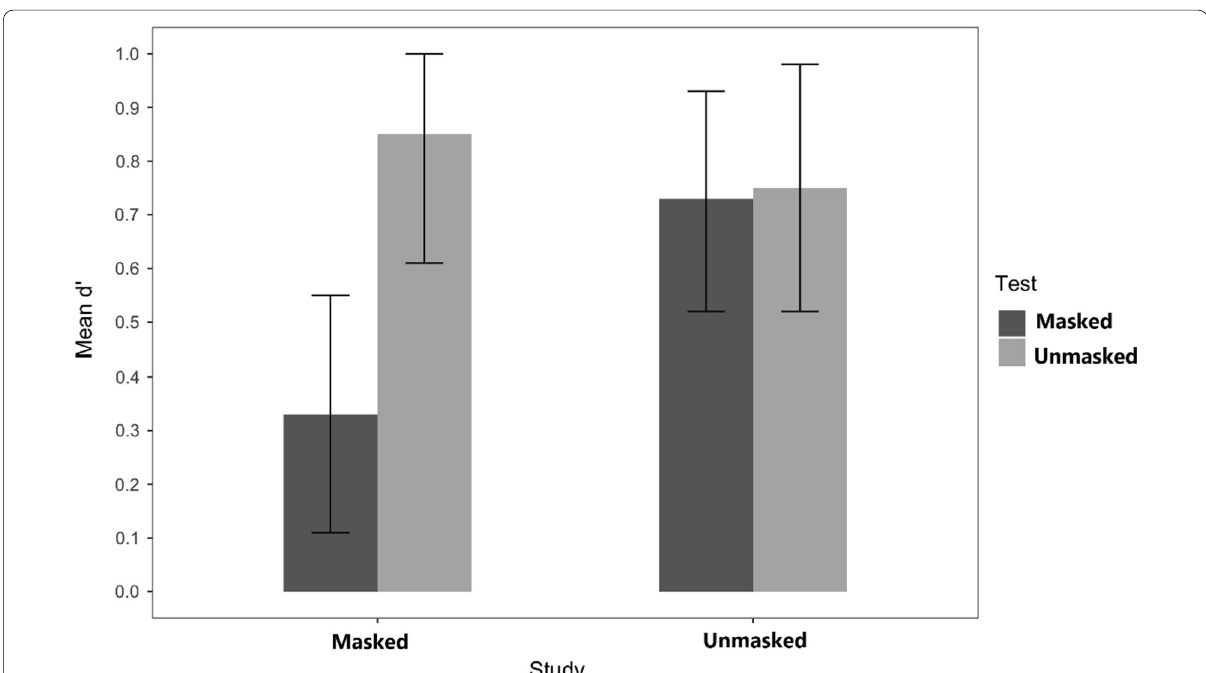
Fig. 7 Experiment 3: Sensitivity d’. Note. Mean response sensitivity for faces studied with and without a mask and subsequently tested either with or without a mask (Experiment